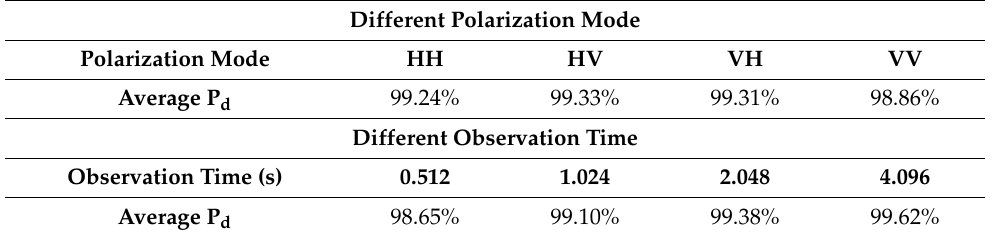
Table 6. Average detection probability of different polarization modes and observation